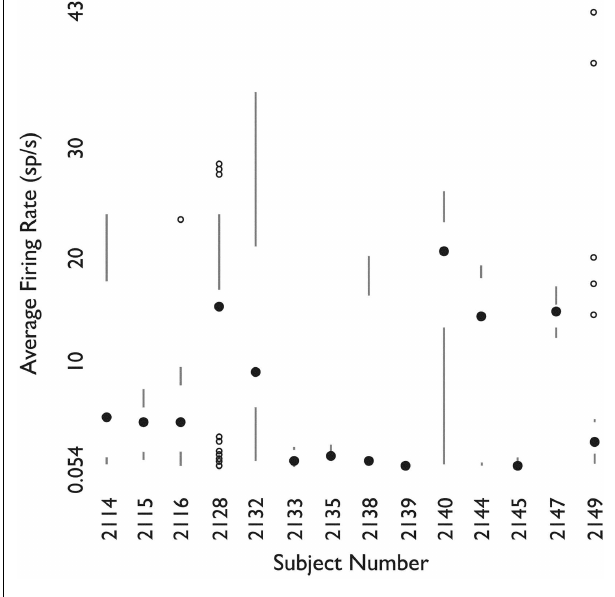
FIGURE 7 | Firing rates of neurons grouped by patient . For each patient, shown as one column, the filled circle shows the median firing rate.The bars above (below) extend from the third (first) quartile to the data point furthest from the median not more than 1.5 times the inter-quartile range from the median. Points further from the median are shown as small open circles. Used with permission from Barrow Neurological Institute.